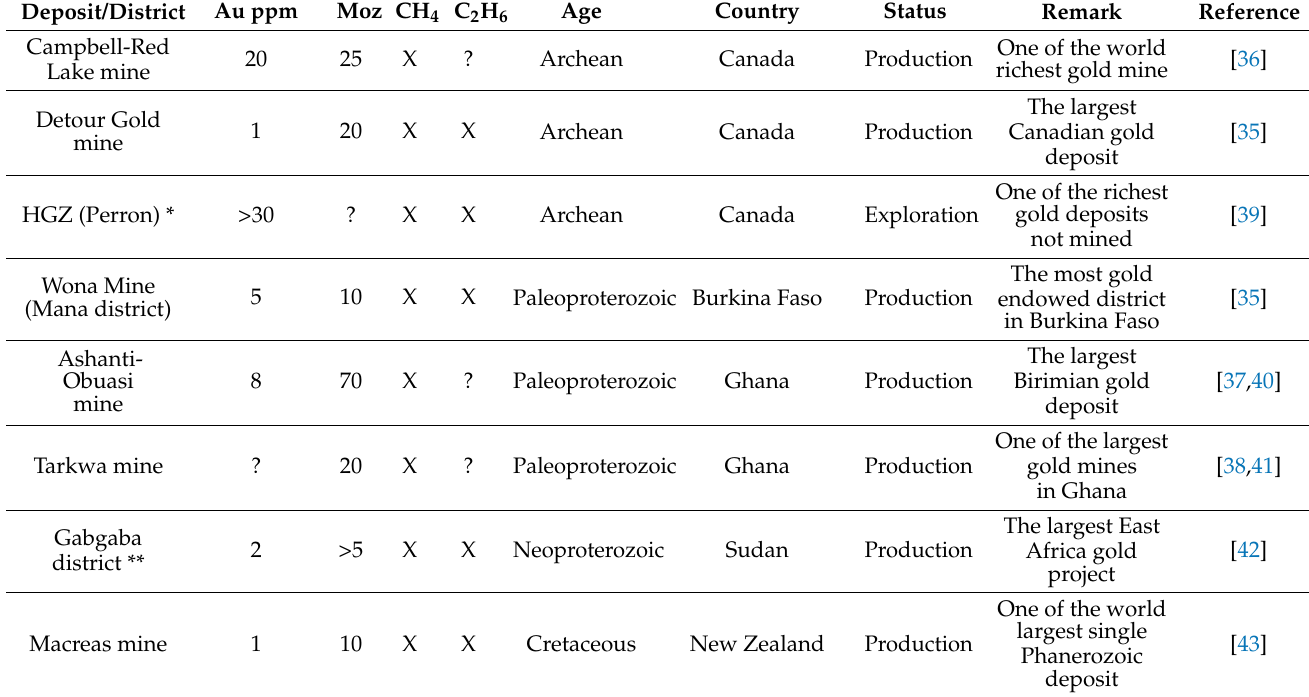
Table 1. Selected examples of large and/or rich gold orogenic gold